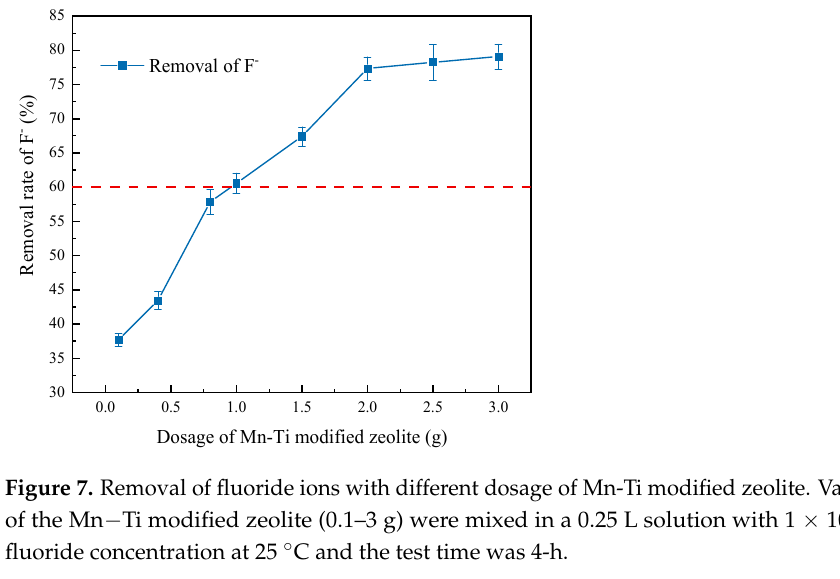
(2) Table 2. Fitted parameters of kinetic models . Lagergren